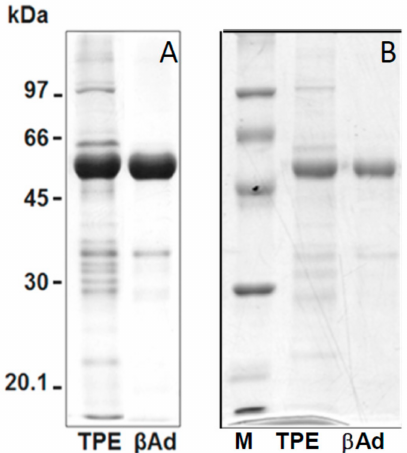
Figure 3. SDS-PAGE profile under reducing conditions of ( A ) isolated with the procedure detailed in Figure 2, and ( B ) chromatografically purified β -vignin. Molecular masses of protein markers are expressed as kDa. TPE represents the total protein extract from adzuki bean